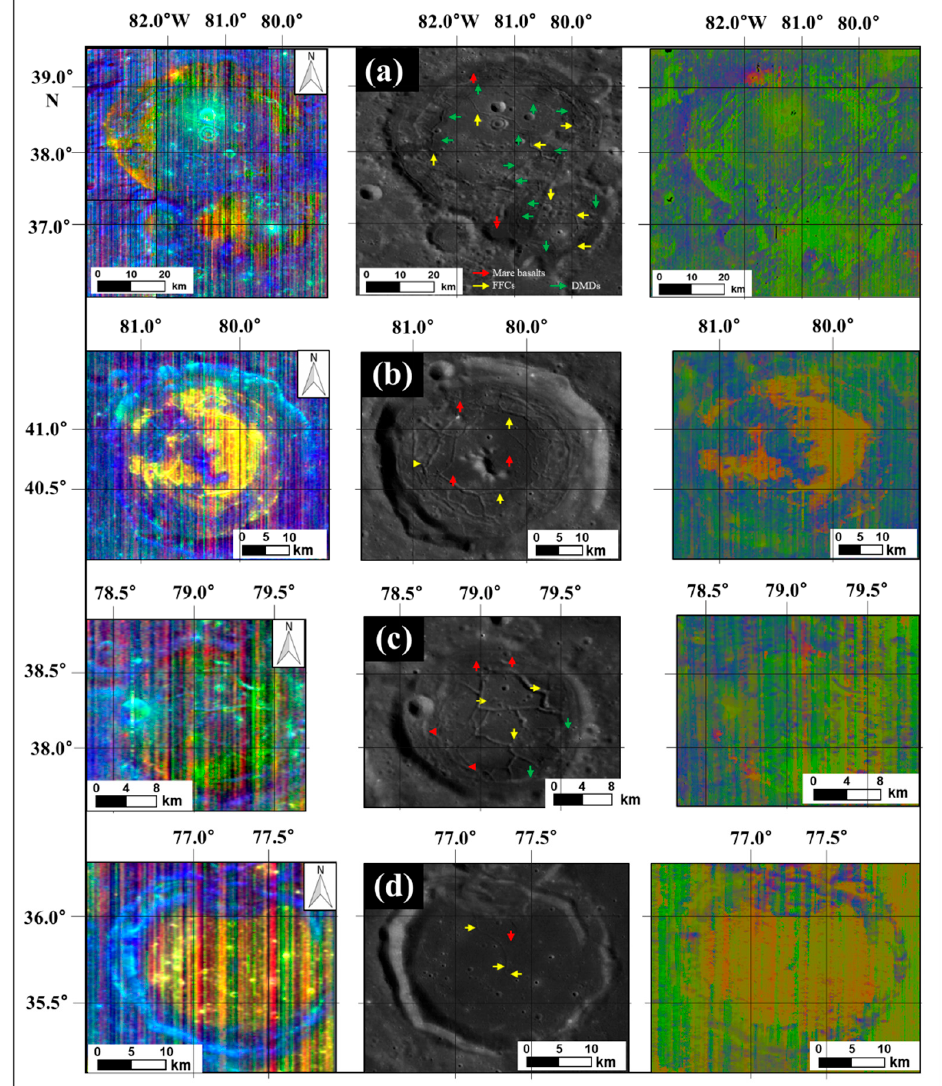
Figure 4. WAC base map ( middle ), mineralogical maps ( left ) using the M³ level 2 data, and petrological maps obtained based on M³ level 1b data ( right ) (see [28,34–36]) of the study area. The red arrows indicate the mare basalts in the WAC base map (middle) and the yellow arrows indicate the floor-fractured craters (FFCs). The green arrows correspond to the dark mantle deposits (DMDs) from Souchon et al. [57]. The false colors of the left RGB composites denote the IBD1000 (red), IBD2000 (green), and 1578 nm albedo (blue). The false colors in the right RGB composite correspond to mare basalts (red), Mg-rich rocks (green), and anorthosite (blue). Regions where mare basalts exist are marked by orange or yellow colors in the two RGB composites. ( a ) Lavoisier and Lavoisier F, ( b ) Lavoisier E, ( c ) Lavoisier H, ( d ) Lavoisier C (the data were downloaded from https://quickmap.lroc.asu.edu, accessed on 1 April 2022). The resolution of the maps is 140 m/pixel